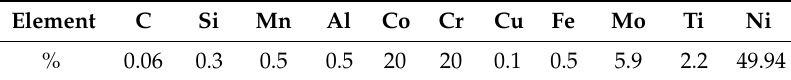
Table 1. Chemical composition of alloy Nimonic 263.